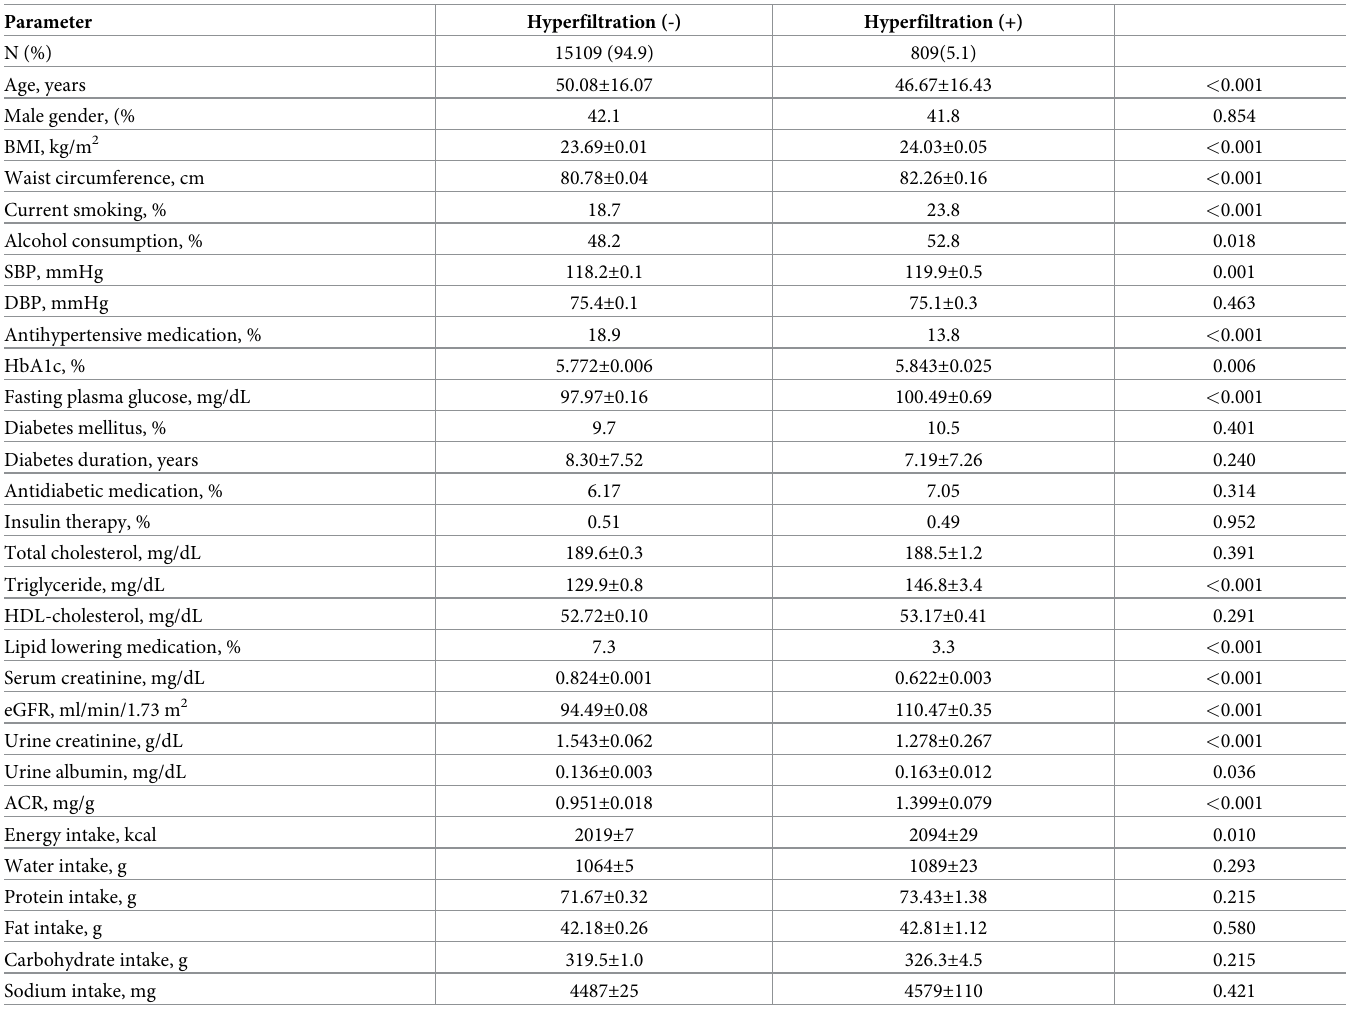
Table 1. Demographic and clinical characteristics of subjects according to hyperfiltration status after adjusting for age, sex, and body